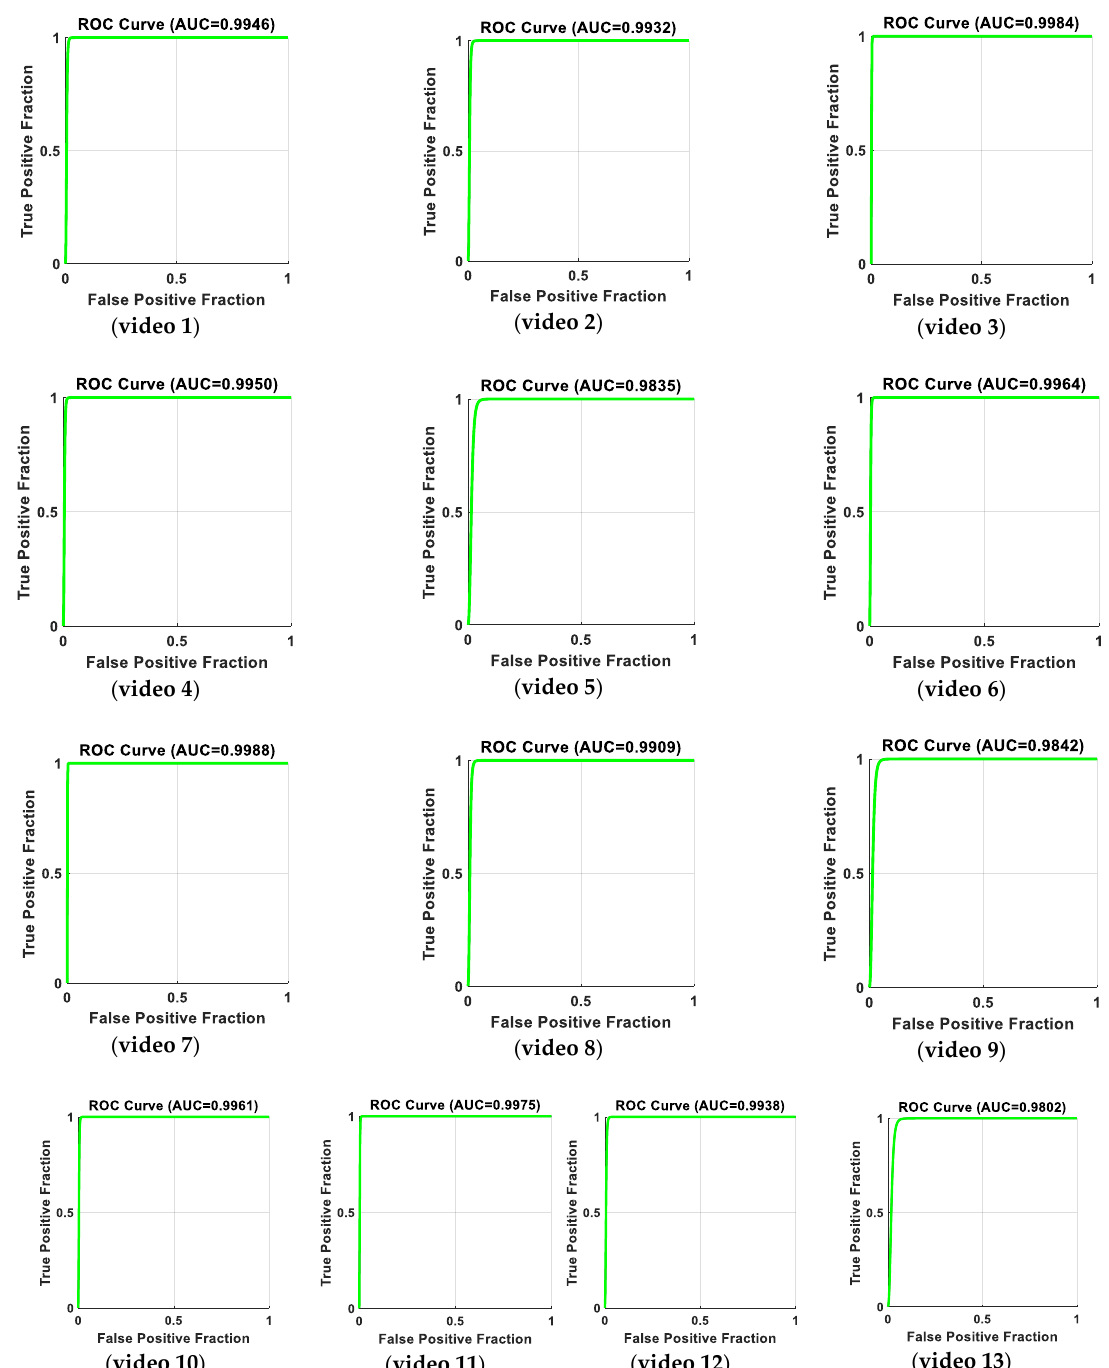
Figure 19. Receiver operating characteristic ( ROC ) curve analysis for the results of the true positive fraction ( A s 1 /( A s 1 + A s 2 )), and false positive fraction ( N s 2 /( N s 2 + N s 1 )), for 13 videos including abnormal and normal events. The results of AUC (area under ROC curve) with respect to the true positive fraction and false positive fraction show that our proposed method is quite capable of distinguishing between the abnormal and normal states.